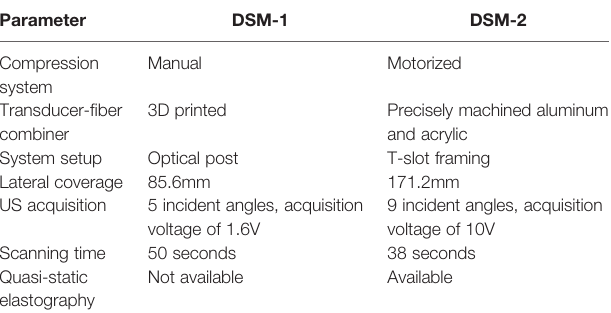
TABLE 2 | Comparison of the system parameters between the fi rst-generation and the second-generation DSM.